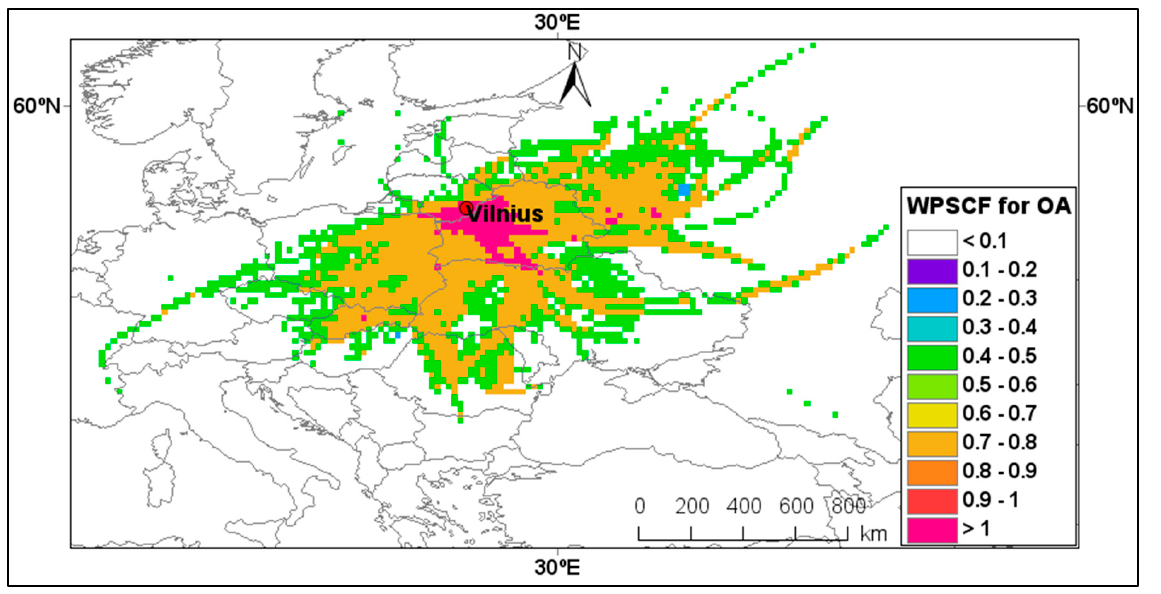
Figure 11. Weighted potential source contribution function (WPSCF) of OA in Vilnius in January and February 2014.